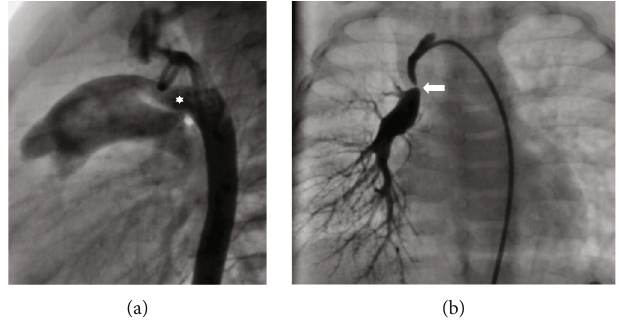
Figure 3: Angiogram showing (a) a large size patent ductus arteriosus (asterisk), and (b) the right pulmonary artery originates from the right subclavian artery with a signi fi cant stenosis at the origin point